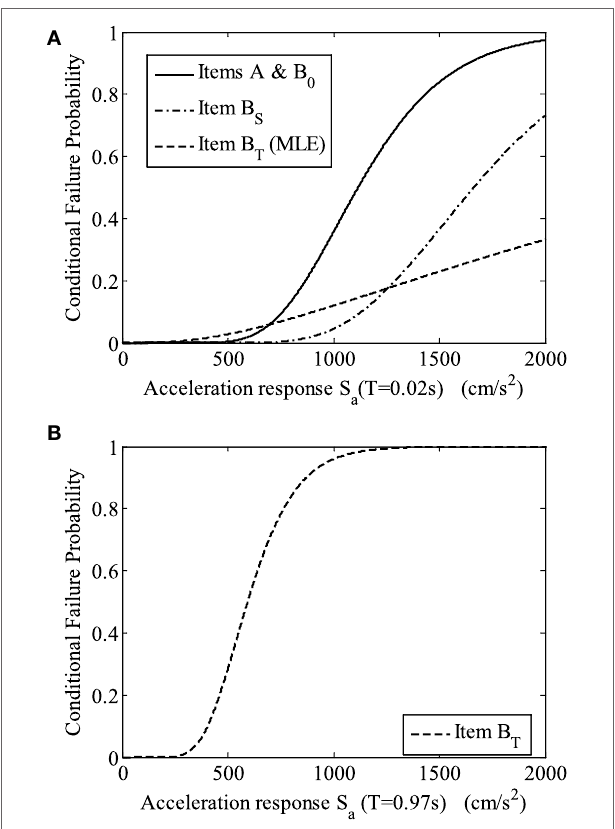
FIGURE 6 | Seismic fragility curves for items B 0 , B S , and B T . As a function of 5% damped spectral acceleration at (A) 0.02s (items B 0 , B S , and B T ) and (B) 0.97s (item B T ).